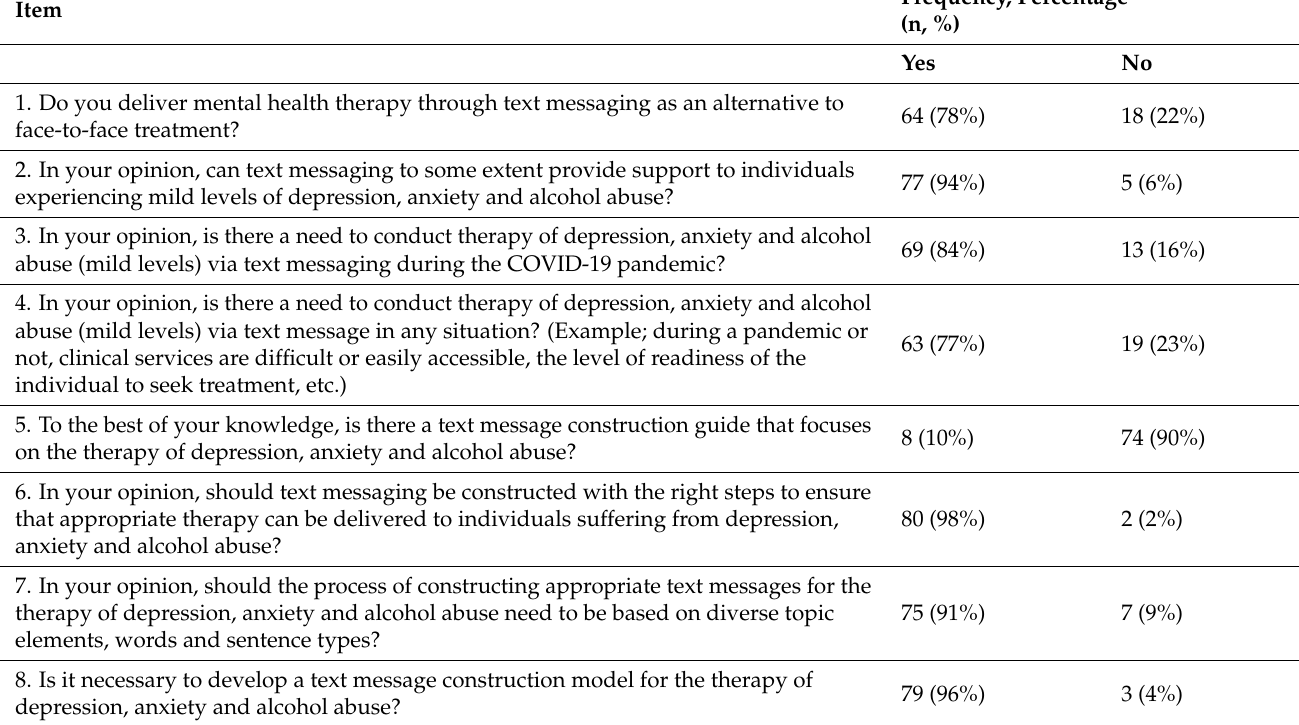
Table 3. Items on Online